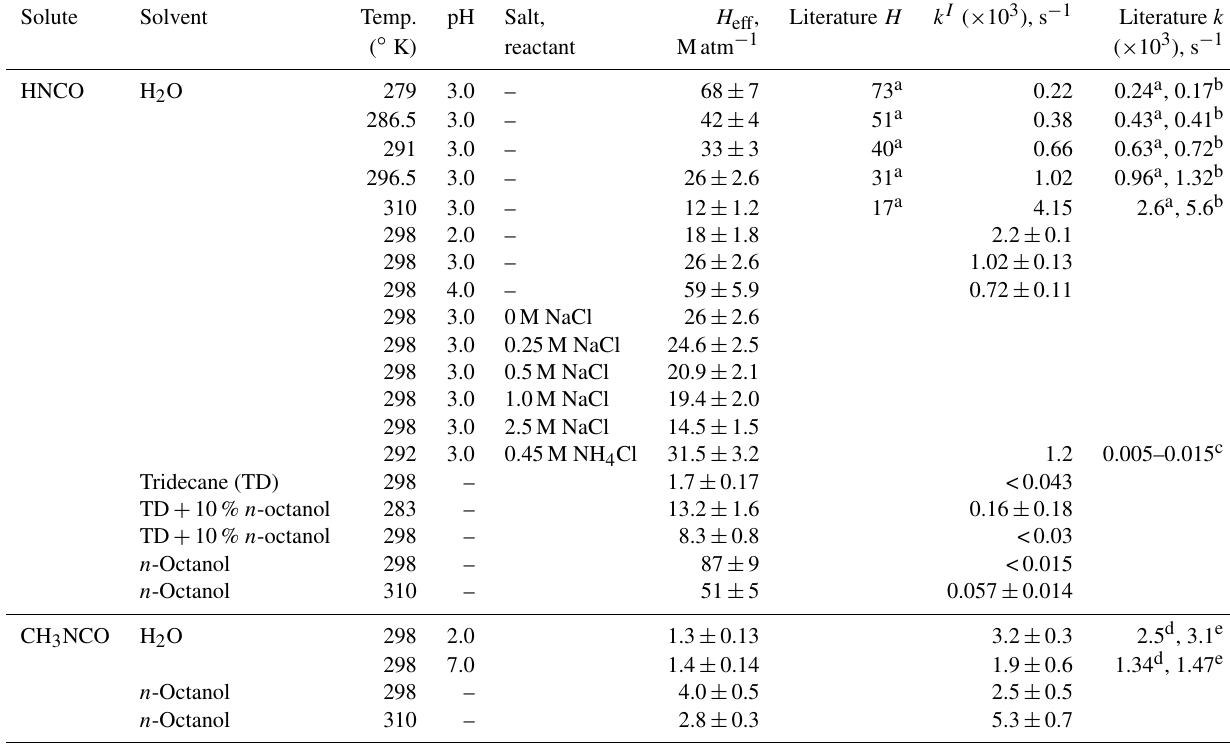
Table 1. Summary of solubility and loss rate measurements of HNCO and CH 3 NCO. Solute